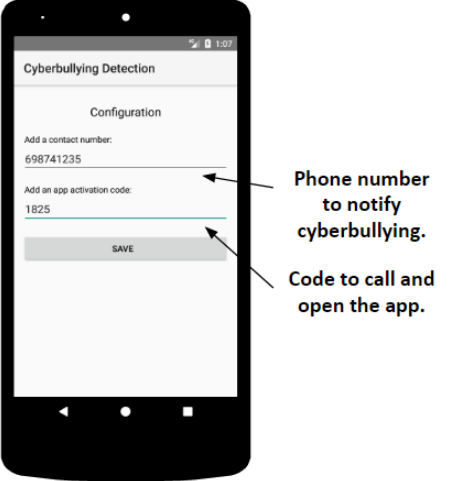
Figure 1. Configuration screen of the mobile